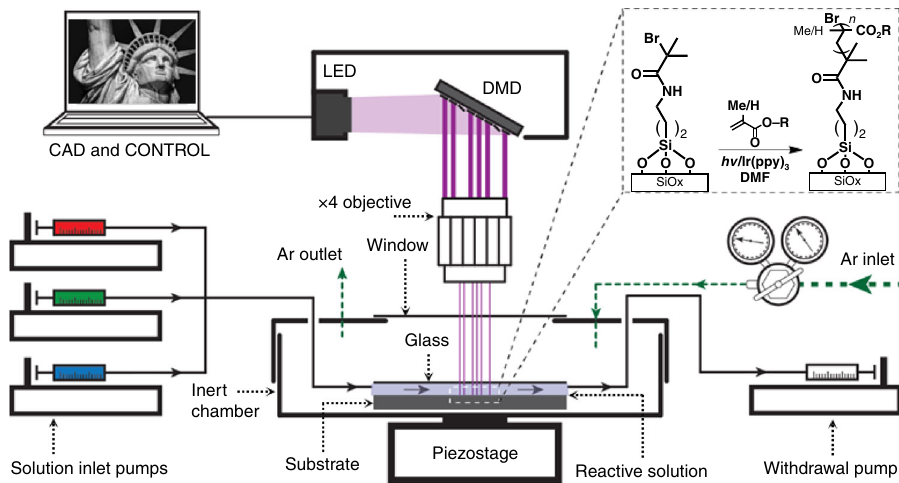
Fig. 1 Photochemical printer. The printer uses micro fl uidics to introduce monomer solutions into the reaction chamber, a computer-controlled DMD to illuminate the surface, and a reaction cell mounted onto a piezoelectric stage to generate multicomponent polymer brush patterns by